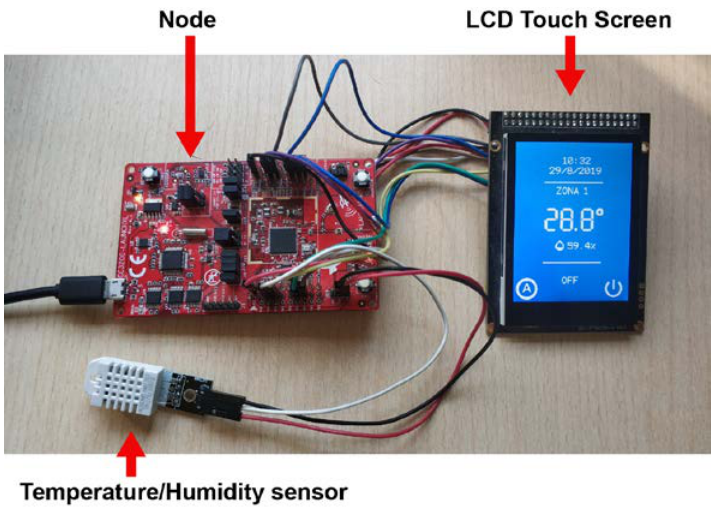
Figure 10. Assembly and main components associated to the Controller and the indoor unit.